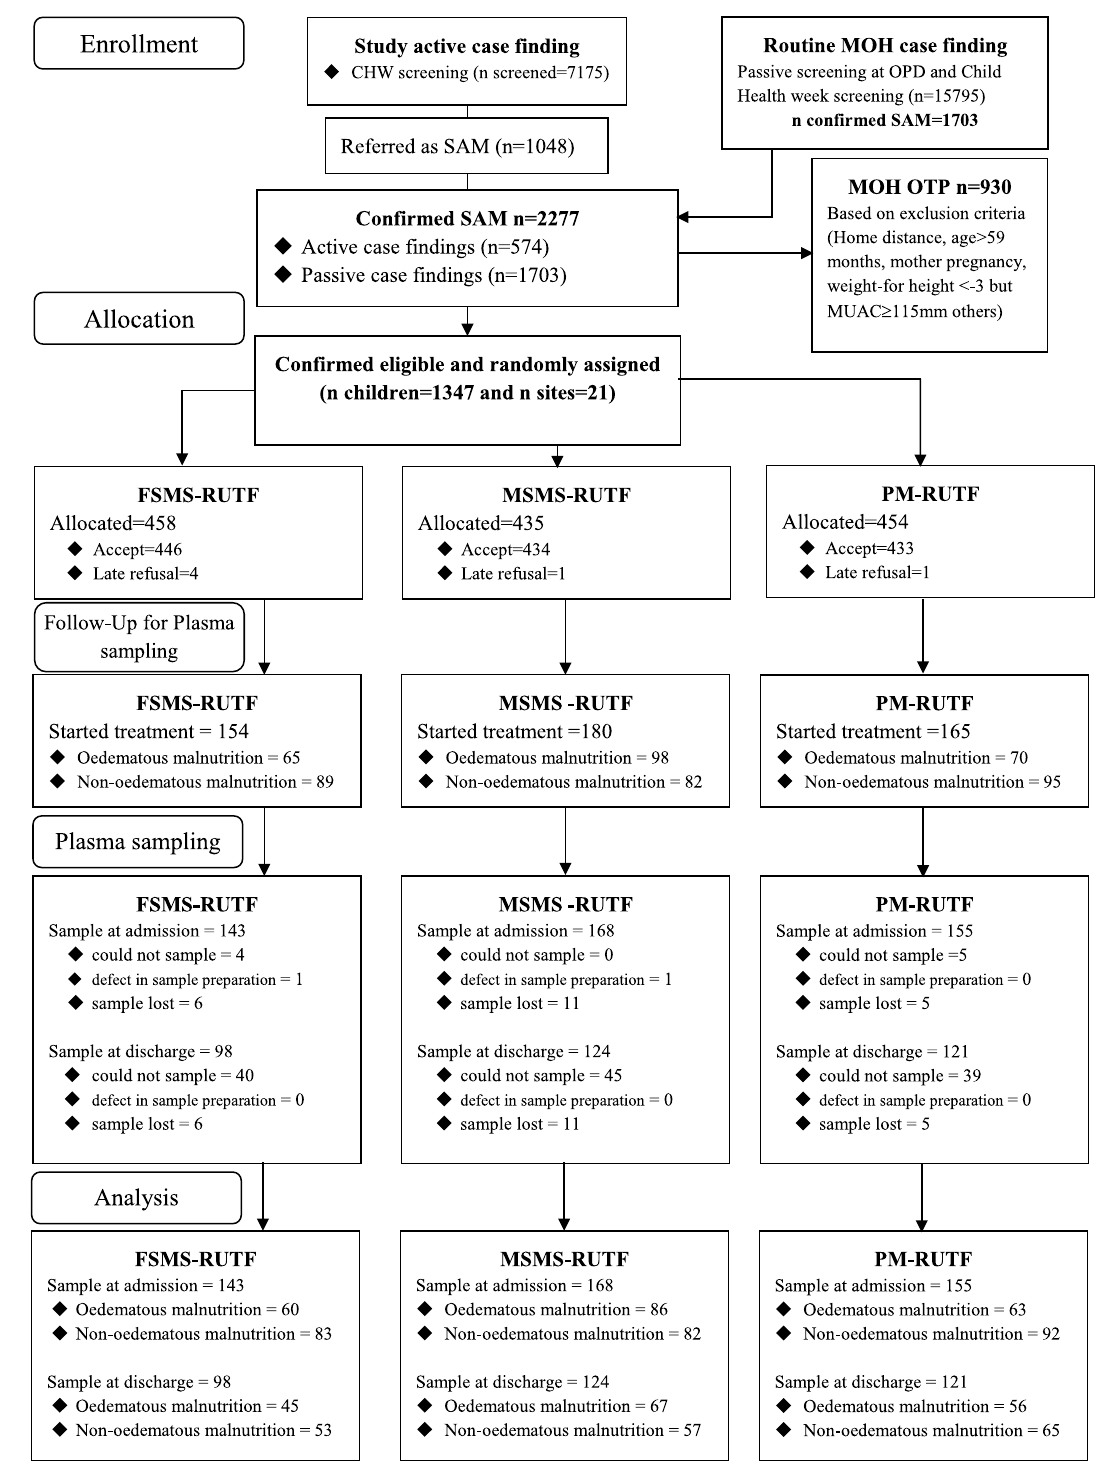
Figure 2. Study participant flow diagram . CHW community health worker, MOH Ministry of Health, OPD outpatient department, OTP outpatient programme, SAM severe acute malnutrition, MUAC mid-upper arm circumference, FSMS milk-free, soya, maize, and sorghum, RUTF ready-to-use therapeutic food, MSMS milk, soya, maize, and sorghum, PM peanut and